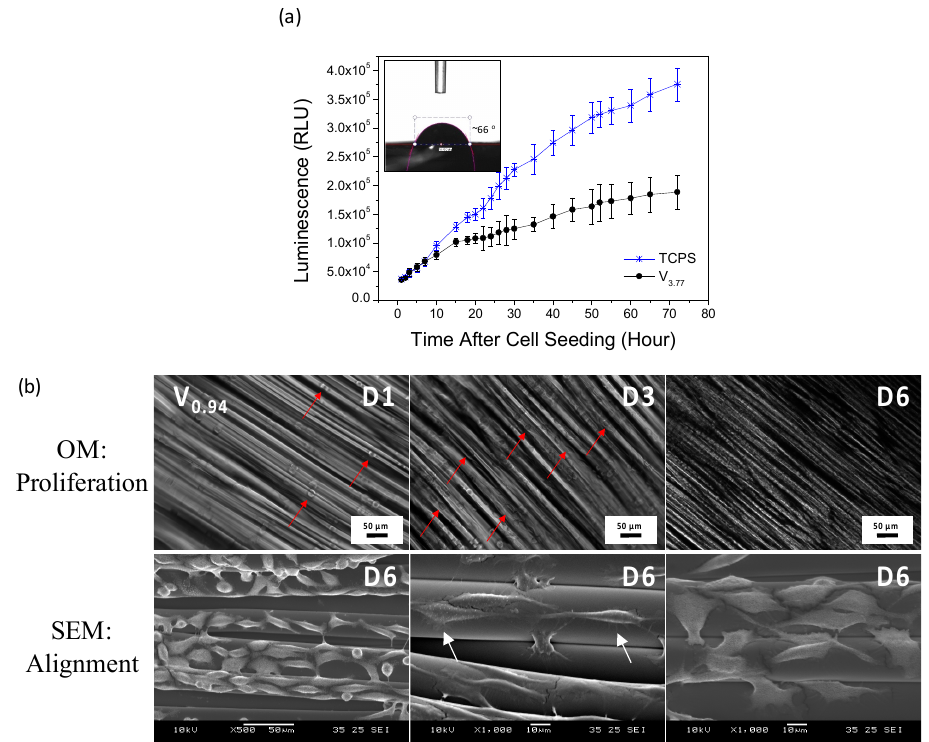
Figure 6. ( a ) Real-time cell proliferation of A10 on the TCPS (control) and the scaffold V 3.77 with initial cell seeding of 2500 cells/scaffold. Inset: water contact angle of PLC scaffold; ( b ) OM images of L929 cell growth and distribution on V 0.94 scaffold for day 1, 3 and 6. SEM images showing the L929 cells elongation and alignment on the scaffold after 6 days of culture.